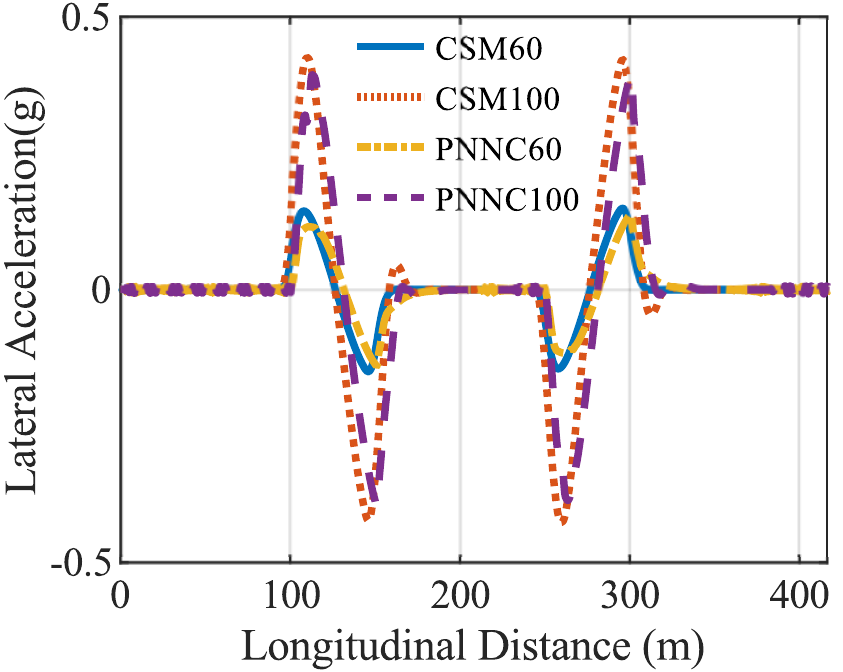
Figure 6. Lateral acceleration of the pure pursuit MPC controller and the proposed Neural Network controller (PNNC) for v x = 60 km/h and v x = 100